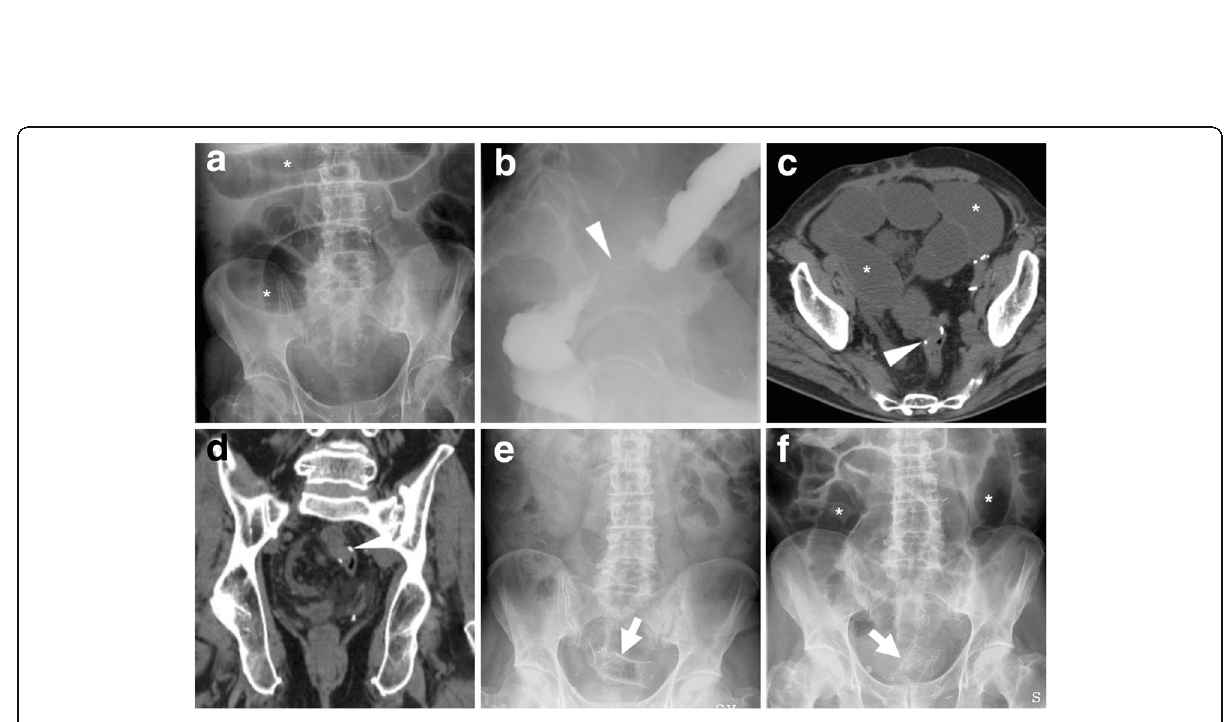
Fig. 10 Stent management of a benign anastomotic stricture and SEMS displacement. In a patient with a history of resected sigmoid CRC, plain radiographic ( a ) shows LBO (*). Fluoroscopic contrast enema ( b ) and endoscopy confirm a tight stricture at the site of colorectal anastomosis (arrowhead in b ) located 12 cm above the anal verge. Noncontrast CT ( c , d ) confirms fluid-filled dilated colon (*), without abnormal mural thickening or extraluminal mass at the anastomosis (arrowheads). A SEMS (thick arrows) was placed through the stricture ( e ). Unfortunately, LBO (* in f ) ultimately recurred after SEMS